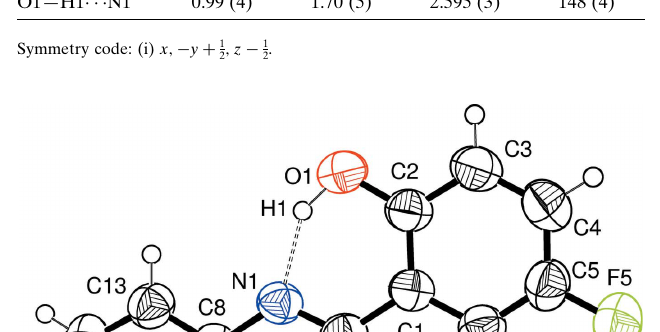
Table 2 Experimental details. Crystal data Chemical formula